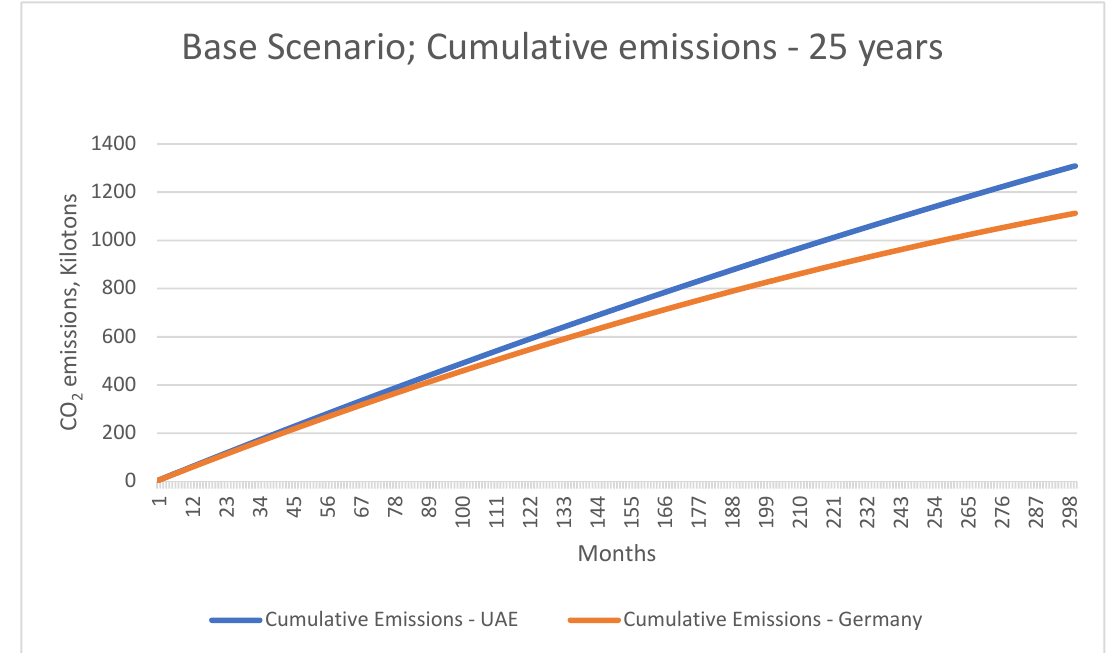
11 of 22 Figure 4. Sensitivity of the model to grid electricity tariff. 3.2. Base Scenario